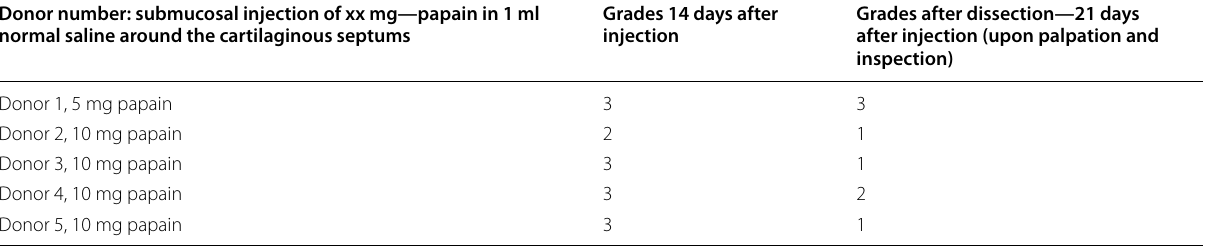
Table 2 The data in the cadaver study in which donors received an injection of papain around the cartilaginous part of the nasal septum